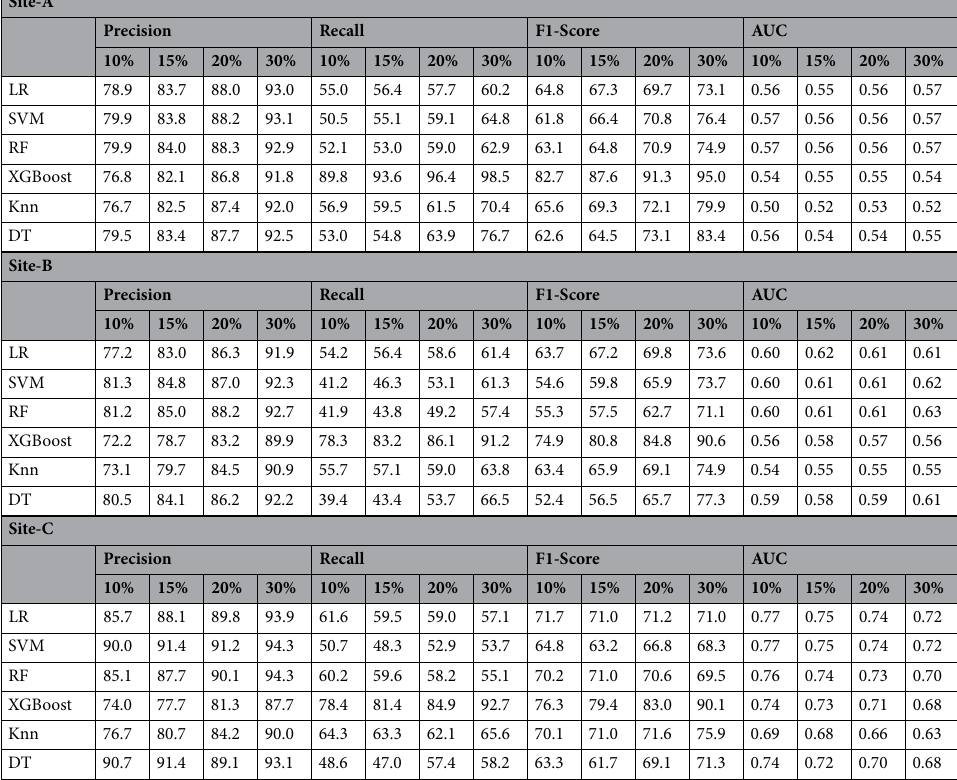
Table 4. Prediction performance of various ML models in classifying patients with a decrease in EF values from their baseline versus patients whose EF values increased or no